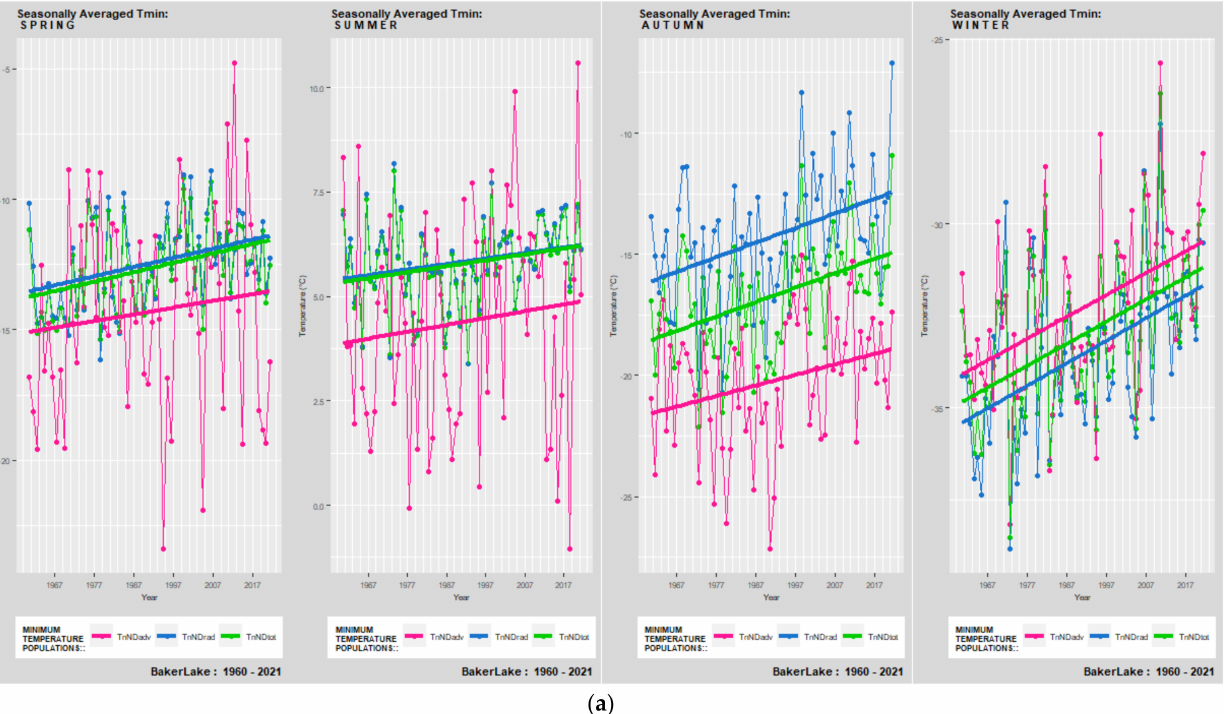
Figure 12. Mackenzie District (MCD); Norman Wells (NT). Seasonally averaged daily temperature minima ( a ) and maxima ( b ), listed in order of Spring, Summer, Autumn, and Winter. ( a )—Total Temperature Minimum ( TT n ) (green), Radiative Temperature Minimum ( RT n ) (blue), and Advective Temperature Minimum ( TT n ) (pink); ( b )—Total Temperature Maximum ( TT x ) (brown), Radiative Temperature Maximum ( RT x ) (orange), and Advective Temperature Maximum ( TT x ) (purple).